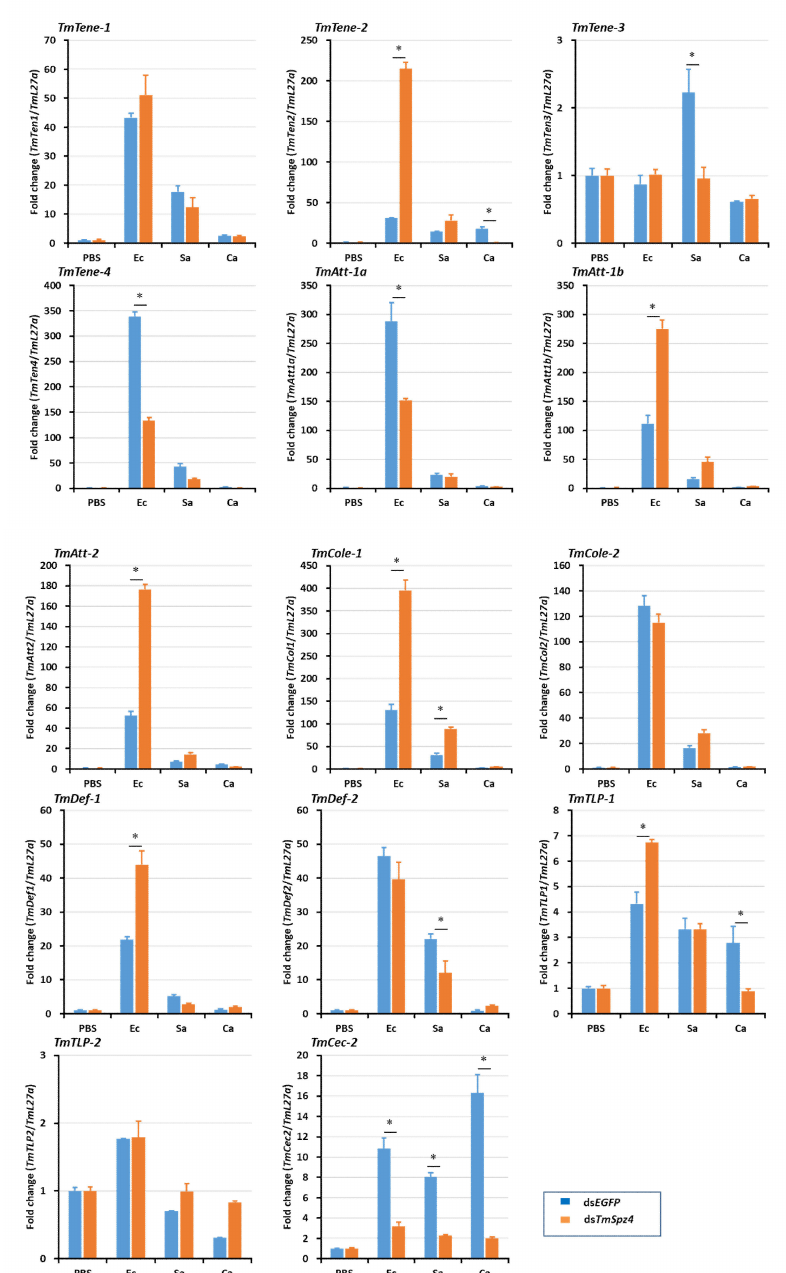
Figure 7. Antimicrobial peptide (AMP) induction patterns in gut of TmSpz4 -silenced larvae. The antimicrobial peptide expression levels in TmSpz4 -knock-down of T. molitor larval gut were performed by injecting either E. coli (Ec), S. aureus (Sa), or C. albicans (Ca). PBS was injected as a control 5 days post- TmSpz4 silencing. At 24 h post-microbial challenge, the expression levels of several AMP genes, including those of TmTen-1 , TmTen-2 , TmTen-3 , TmTen-4 , TmAtt-1a , TmAtt-1b , TmAtt-2 , TmDef-1 , TmDef-2 , TmCol-1 , TmCol-2 , TmCec-2 , TmTLP-1 , and TmTLP-2 , were measured by qRT-PCR. ds EGFP was injected as a negative control, and TmL27a expression was measured as an internal control. All experiments were performed in triplicate. Asterisks indicate significant di ff erences between ds TmSpz4- and ds EGFP- treated groups when compared by Student’s t-test ( p < 0.05). E ff ects of TmSpz4 on the expression patterns of NF- κ B